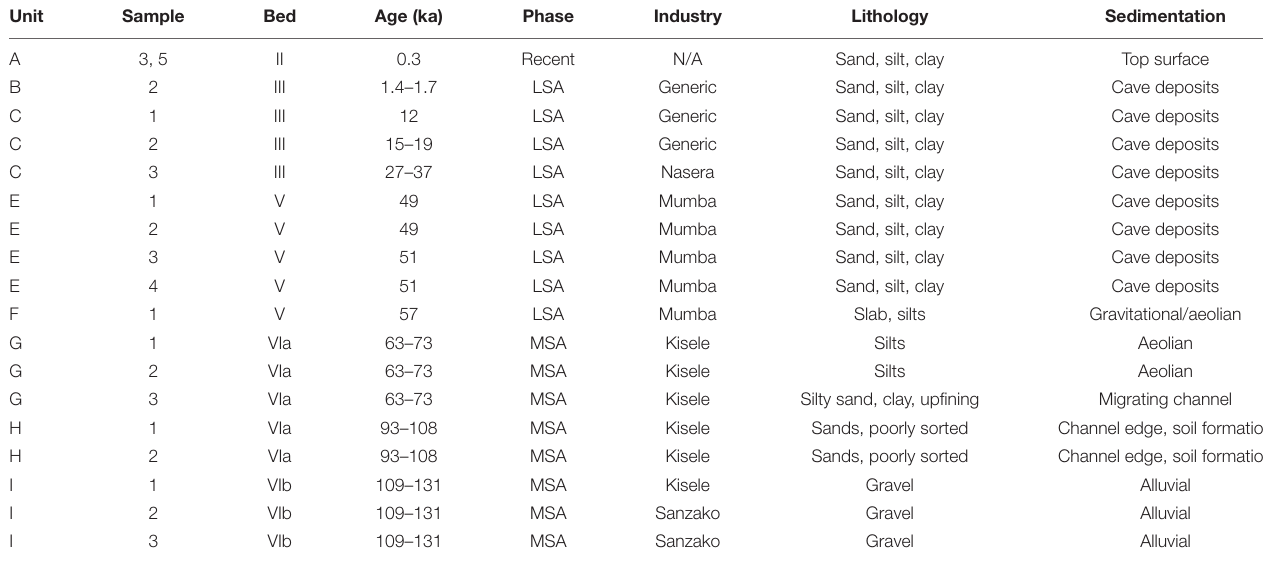
TABLE 1 | Samples studied in this article: stratigraphic provenance, age, cultural affiliation, and sedimentary characteristics.